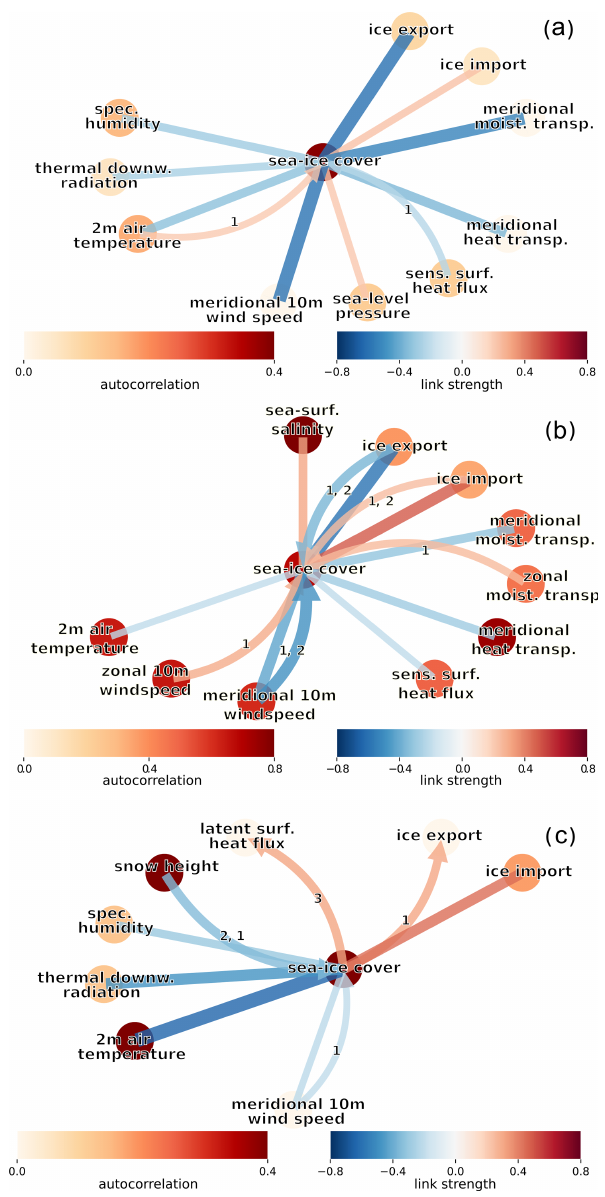
Figure 7. Causal-effect networks considering atmospheric variables over the whole Laptev Sea region land and ocean area for ice melt and ice refreeze. (a) Ice-melt monthly mean. The connections in be- tween the variables (not shown) have a mean strength of 0 . 44. Con- temporary connections between surface longwave downward radi- ation, air temperature and specific humidity are especially strong (0.77). The same goes for sea-ice import and export, meridional wind speed, and heat and moisture transport (0.626). (b) Ice-melt daily means. Similar variables are dominant compared to panel (a) , but more causal links are detected. Note that the color scale for autocorrelation is different compared to panel (a) and (c) . (c) Ice- refreeze monthly mean. Connections between variables (not shown) have a mean strength of 0.44. Contemporary connections between surface longwave downward radiation, air temperature and specific humidity are especially strong